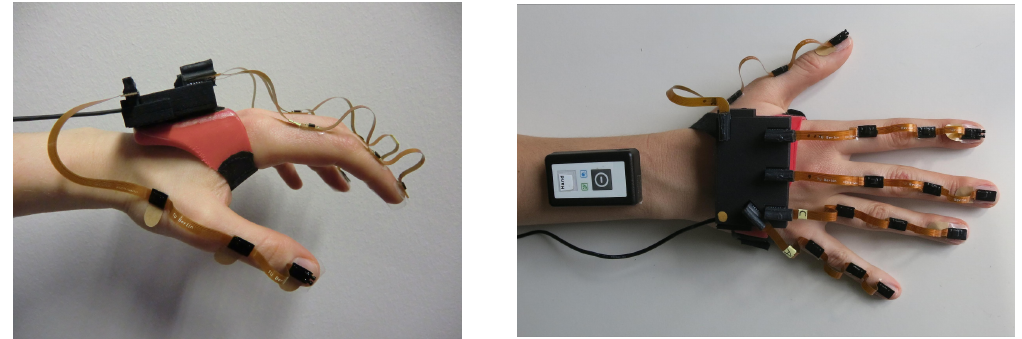
Figure 1. IMU-based modular hand sensor system for real-time motion tracking of the fingertip positions. The system consists of a base unit on the hand back, a wireless IMU on the forearm, and up to five sensor strips, each equipped with three